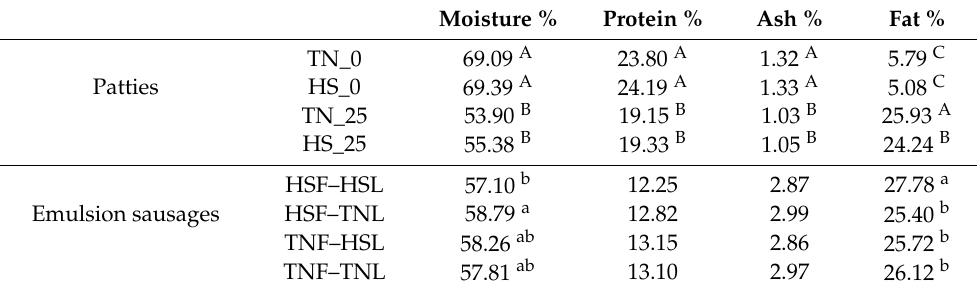
Table 3. Proximate composition of pork patties and emulsion sausages.